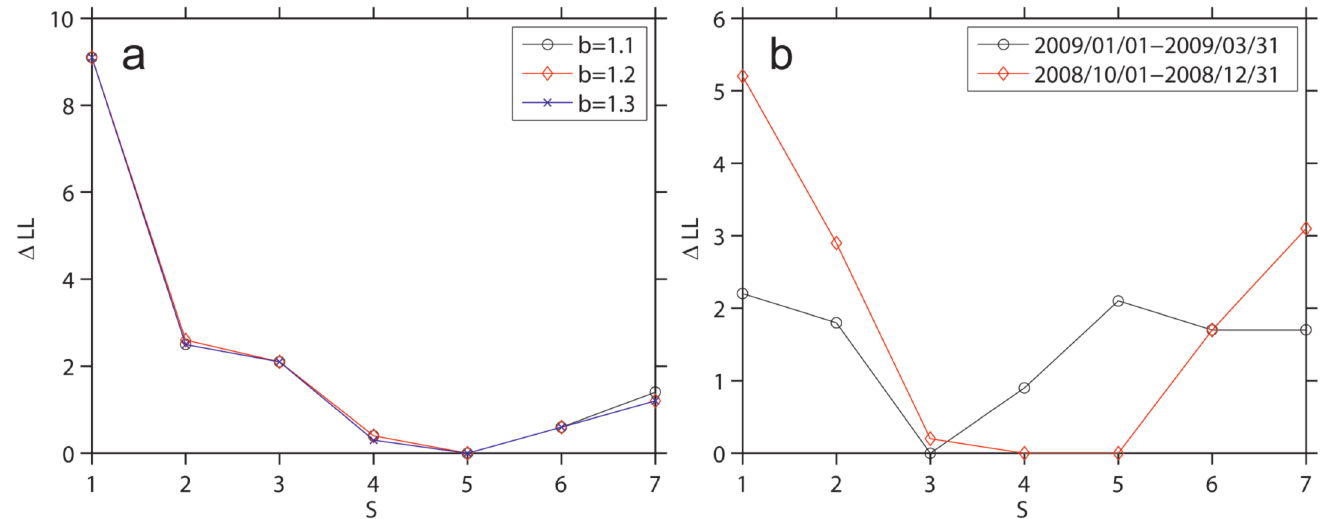
Figure 4. D LL as a function of S . (a) Retrospective forecast period from t that occurred during this period. We considered b = 1.2 (red diamonds). Also included is the D LL - S dependence for b = 1.1 (black circles) and 1.3 (blue crosses). (b) Retrospective forecast periods from t 31, 2008 (red diamonds). Targets are 6 and 9 earthquakes with 3.5 ≤ M ≤ 9 for the former and latter periods,